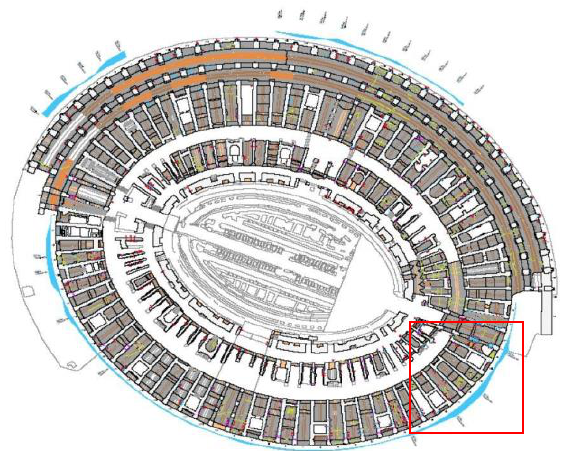
Figure 13. In red the area analysed is highlighted, while the out of plane intensity of the façade is shown in light blue colour.